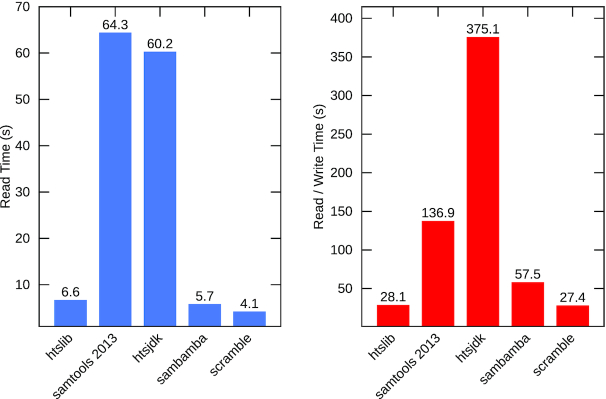
BAM elapsed read/write times, with up to 16 threads available.